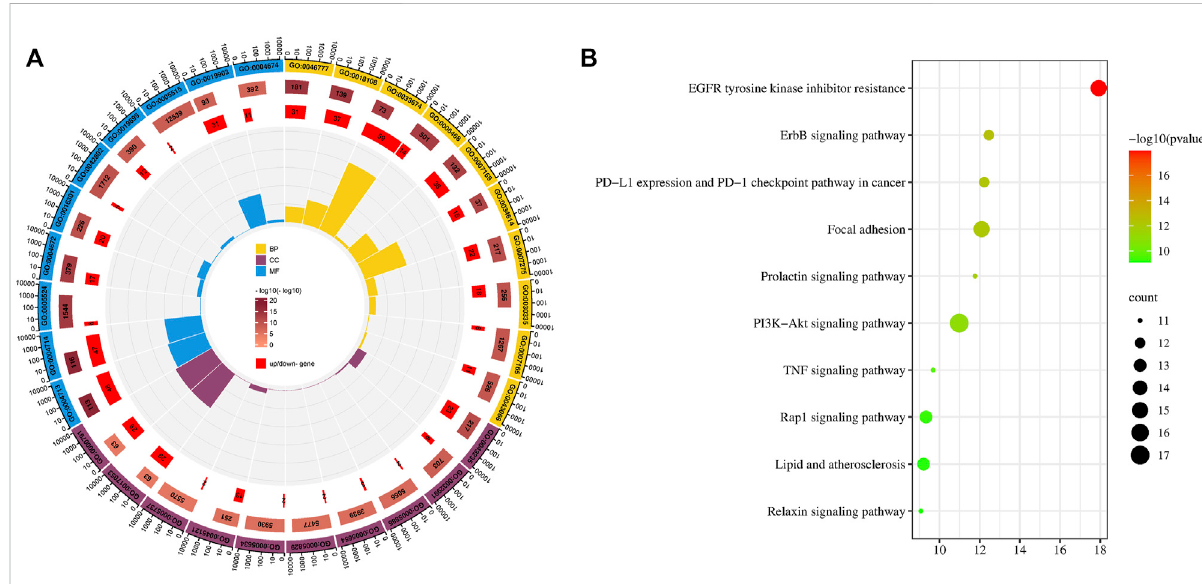
FIGURE 1 GOandKEGGanalysis. (A) ToptenitemofGOenrichmentanalysisofbiologicalprocesses(BP),cellcomponents(CC),andmolecularfunctions (MF). (B) Bubble diagram of KEGG